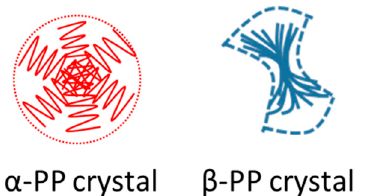
Figure 1. Schematic representation of α and β crystals of polypropylene (PP) showing a spherical and banded structure, respectively, as they would be seen under polarized light microscopy. The dotted lines contour the simulated PP chain to highlight their different arrangements in the two crystals.